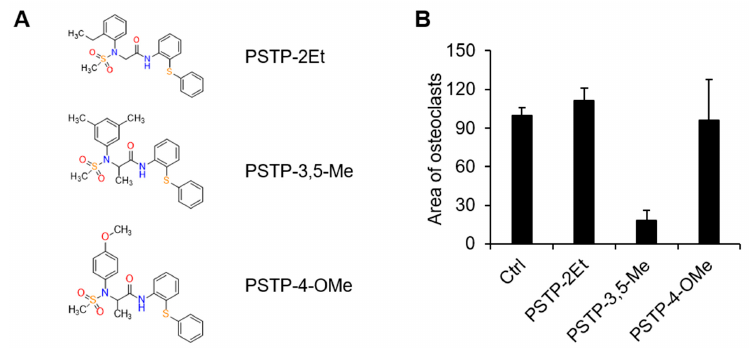
Figure 1. Screening of the PSTP compounds for their e ff ect on osteoclastogenesis. ( A ) The structures Figure 1 . Screening of the PSTP compounds for their effect on osteoclastogenesis. ( A ) The structures of PSTP-2Et, N -2-(2-ethylphenyl)- N -2-(methylsulfonyl)- N -1-[2-(phenylthio) phenyl] glycinamide; PSTP-3,5,-Me,